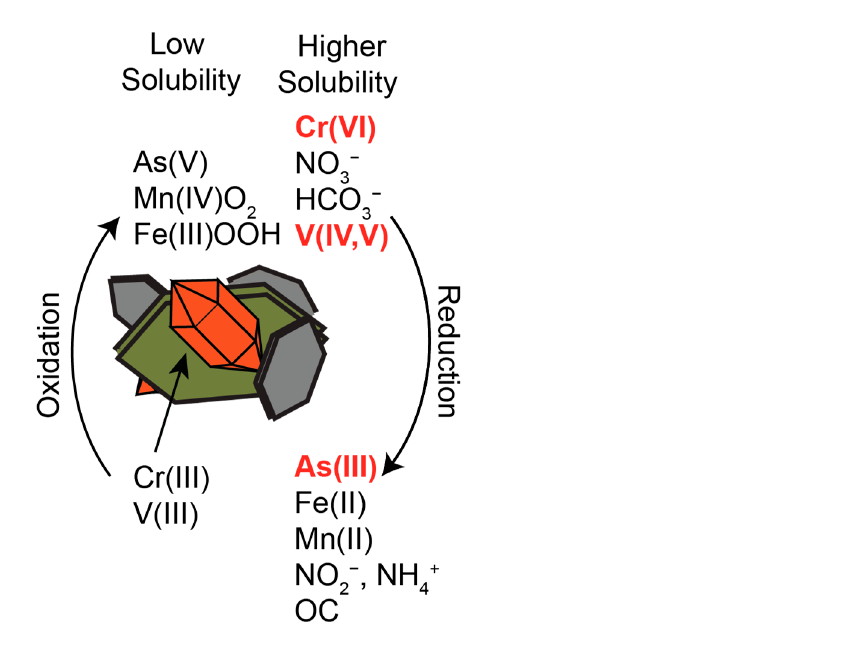
Figure 4. Redox controls on elemental mobility and toxicity that highlights contrasting redox controlled solubilities of As, V, and Cr. Low solubility species tend to form precipitates or sorb strongly to aquifer materials. Red indicates the oxidation states thought to pose more threat to health. OC = organic carbon.